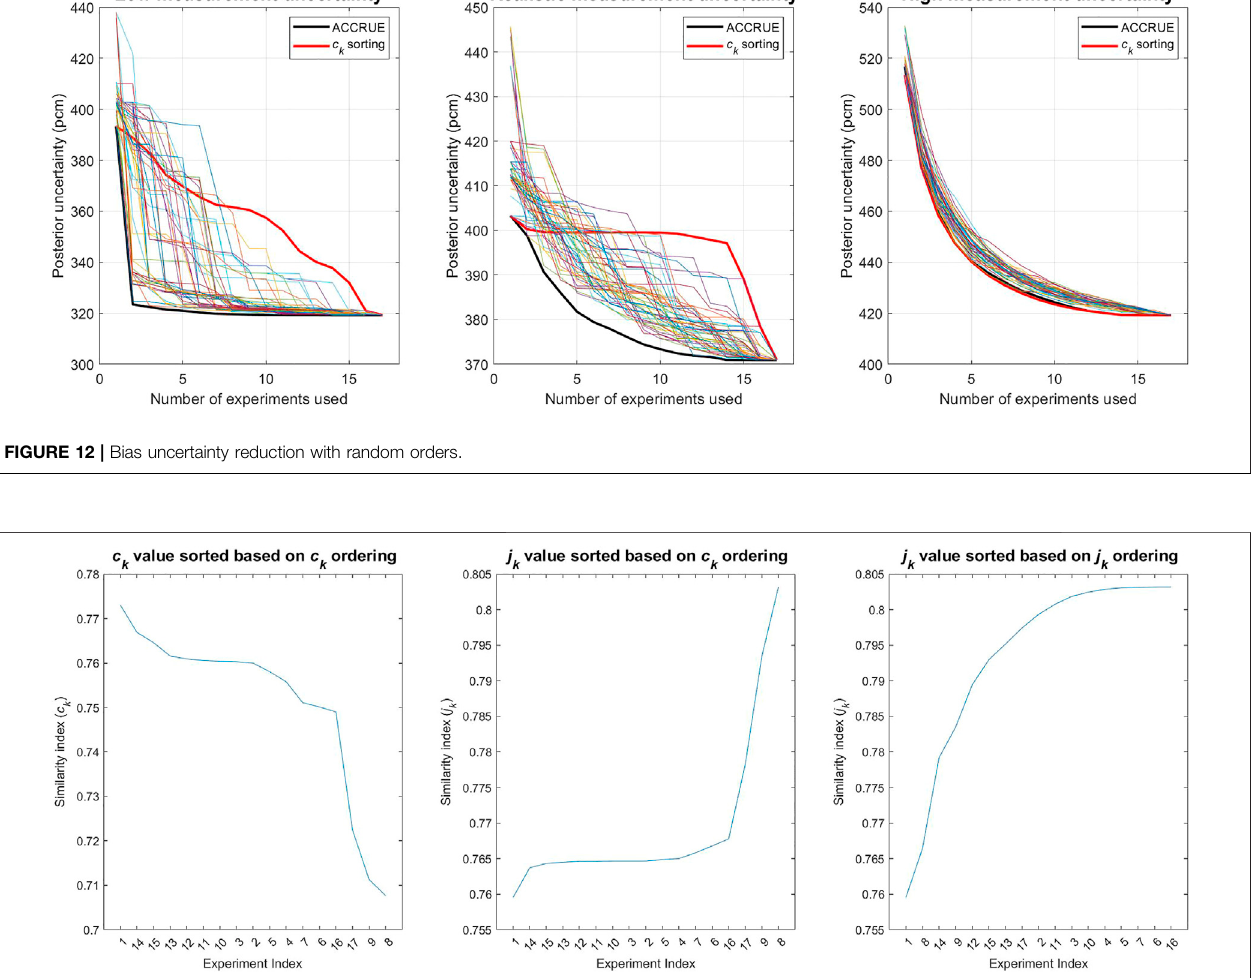
FIGURE 13 | Comparison of the c k and j k pro fi